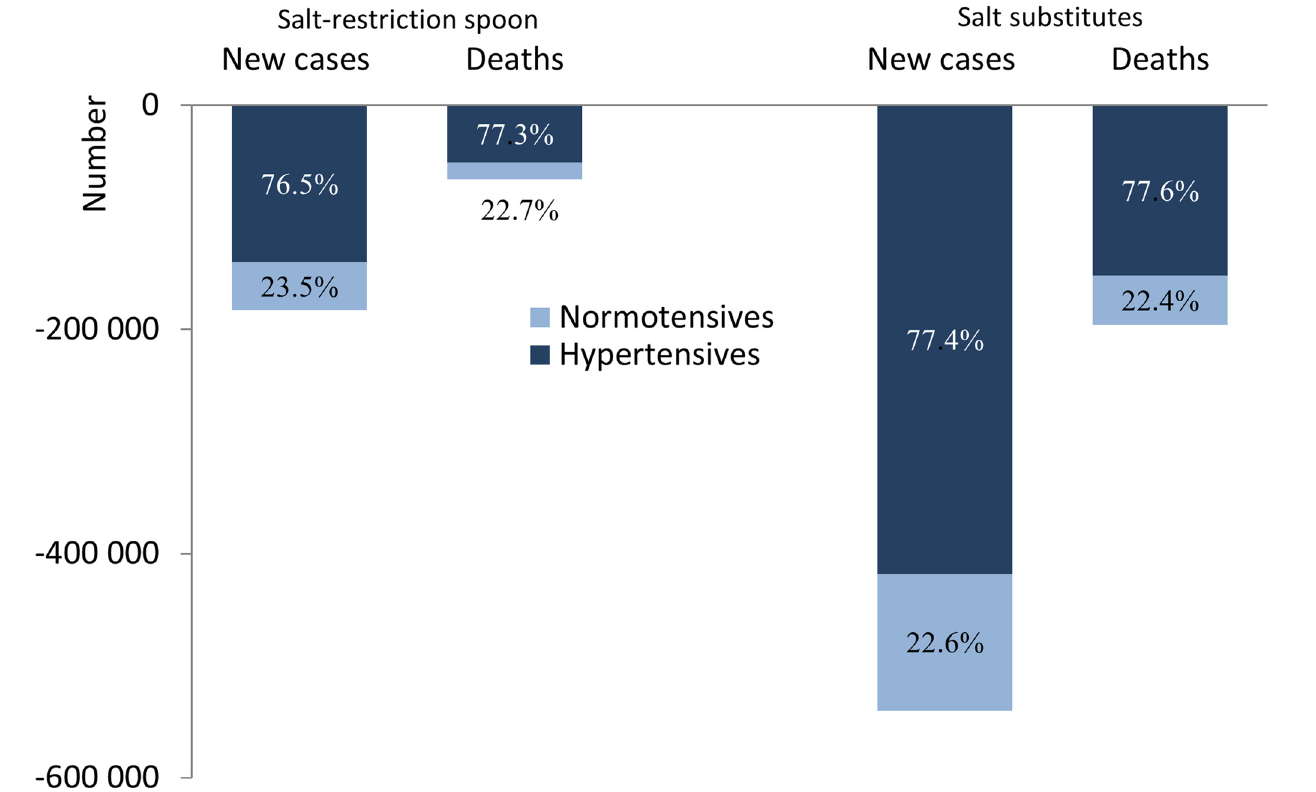
Fig 3. Simulated annual number of CVD events prevented by salt restriction strategies by hypertension